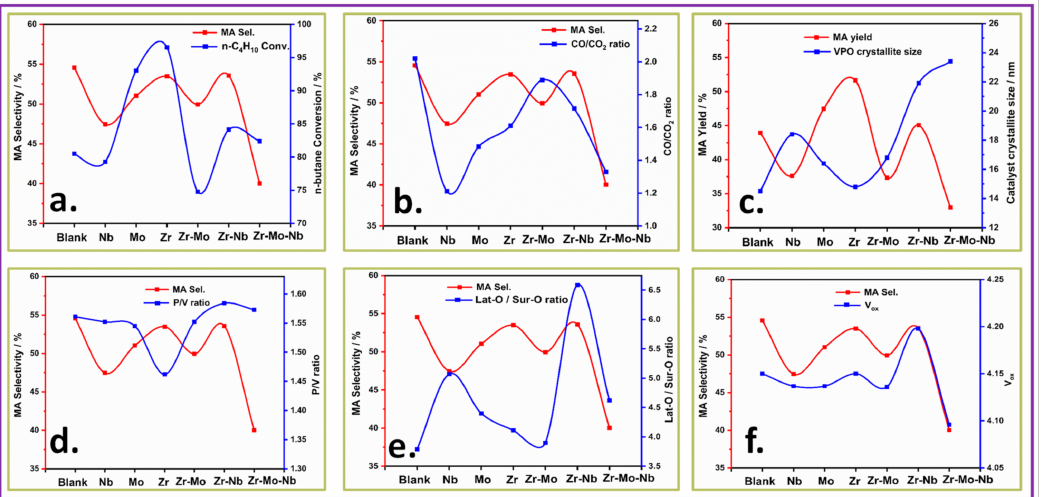
Figure 19. MA selectivity is dependent on n-butane conversion ( a ), the molar ratio of CO/CO 2 ( b ), crystallite size of the VPO catalyst ( c ), the P/V ratio ( d ), the lattice to surface oxygen ratio (Lat-O/Sur-O) ( e ), and the oxidation state of vanadium (V ox ) ( f